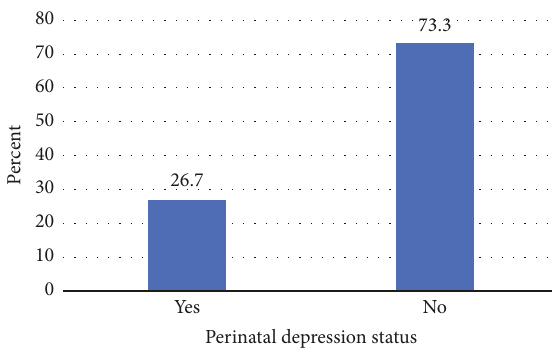
Figure 3: Perinatal depression status of the study participants according to the SRQ-20 in Arba Minch District, Ethiopia, 2017.